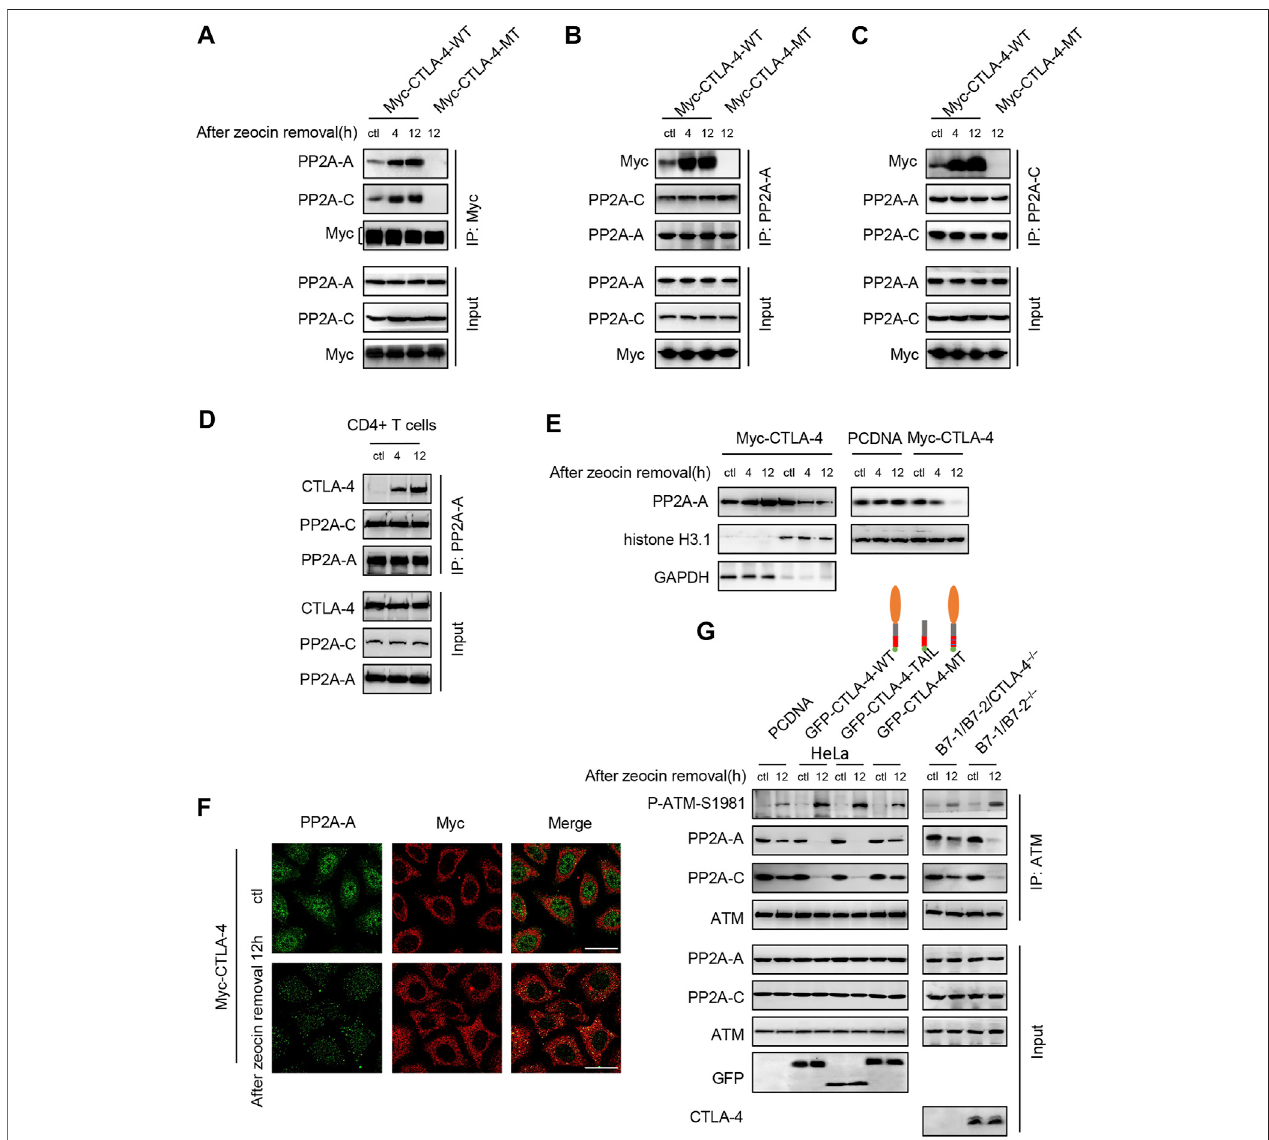
FIGURE 6 | CTLA-4 interacts with PP2A, promotes the translocation of PP2A-A into the cytoplasm, and induces autophosphorylation of ATM at Ser1981 after zeocin treatment. (A – C) Co-IP analysis of the interaction of CTLA-4 with PP2A. HeLa cells were transfected with Myc-CTLA-4-WT and Myc-CTLA-4-MT proteins with the Y201F and Y218F mutations. About 24 h after transfection, the cells were treated with 500 μ g/ml zeocin for 1 h and harvested at the indicated times. (D) For endogenous co-immunoprecipitation experiments, CD4 + T cells from B7-1/B7-2 − / − mice were lysed. (E) Nuclear and cytoplasmic levels of PP2A-A in HeLa cells were detected using western blotting. HeLa cells were transfected with Myc-CTLA-4 (left panel), and pcDNA and Myc-CTLA-4 (right panel) for 24 h. At the indicated times after cessation of treatment, the cells were lysed and separated into nuclear and cytosolic fractions. GAPDH, a marker of the cytosolic fraction; histone H3.1, a markerofthenuclearfraction. (F) Double immuno fl uorescence stainingwasperformedtodetectthePP2A-A and CTLA-4proteins and theircolocalizationinHeLacells. HeLacellsweretransfectedwithMyc-CTLA-4for24 h.Thecellsweretreatedwith500 μ g/mlzeocinfor1 h,harvestedattheindicatedtimepoints,andthensubjectedto immuno fl uorescence staining using speci fi c antibodies against PP2A-A (green), CTLA-4 (red), and Scale bar, 20 μ m. (G) ATM was immunoprecipitated and immunoblotted to detect the levels of P-ATM-S1981, total ATM, and the PP2A-A and PP2A-C subunits. Right panel: HeLa cells were transfected with pcDNA, GFP- CTLA-4-WT, a GFP-CTLA-4-TAIL (tail only) mutant, and GFP-CTLA-4-MT sequences containing Y201F and Y218F mutations. About 24 h after transfection, the cells were treated with 500 μ g/ml zeocin for 1 h and harvested at the indicated time points. The CTLA-4 extracellular domain is shown as orange ovals, the transmembrane domain is indicated by gray bars, the CTLA-4 cytoplasmic tail is shown as red bars, the double-mutant Y201F/Y218 is shown with blue lines, and GFP is indicated by greencircles.Leftpanel:CD4 + TcellsfromB7-1/B7-2 − / − andB7-1/B7-2/CTLA-4 − / − miceweretreatedwith500 μ g/mlzeocinfor1 handthenreleasedandharvestedat the indicated time